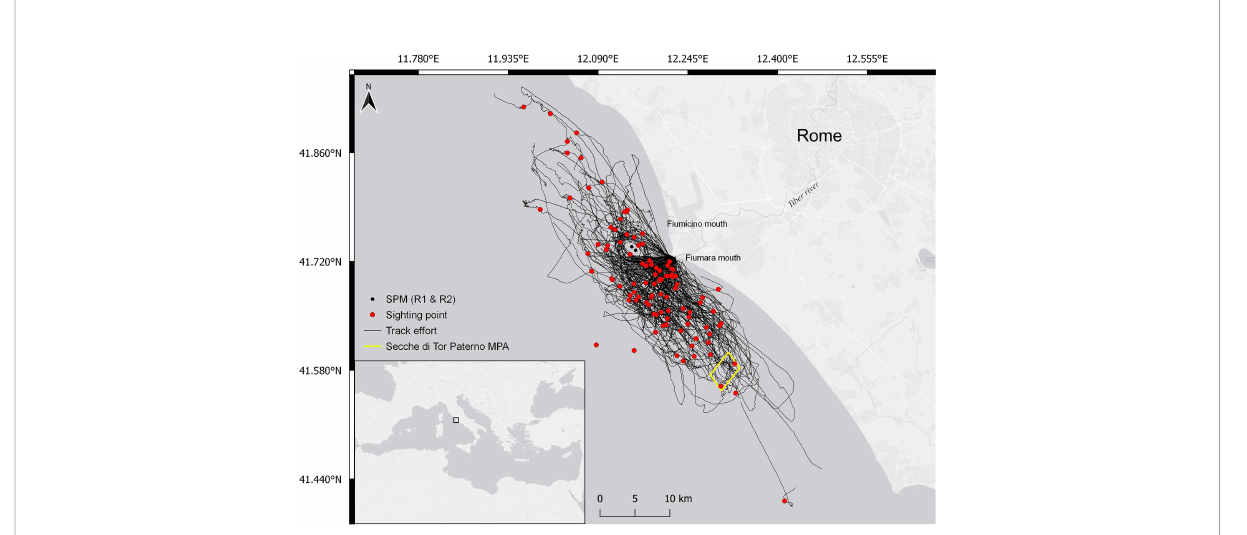
FIGURE 1 Study area in Central Tyrrhenian Sea (Mediterranean Sea, Italy). Black lines represent the 2017 – 2020 survey tracks, red dots correspond to the location of the bottlenose dolphin encounters, black dots identify the two single-point moorings (SPMs), and the yellow square delimits the Secche di Tor Paterno marine protected area